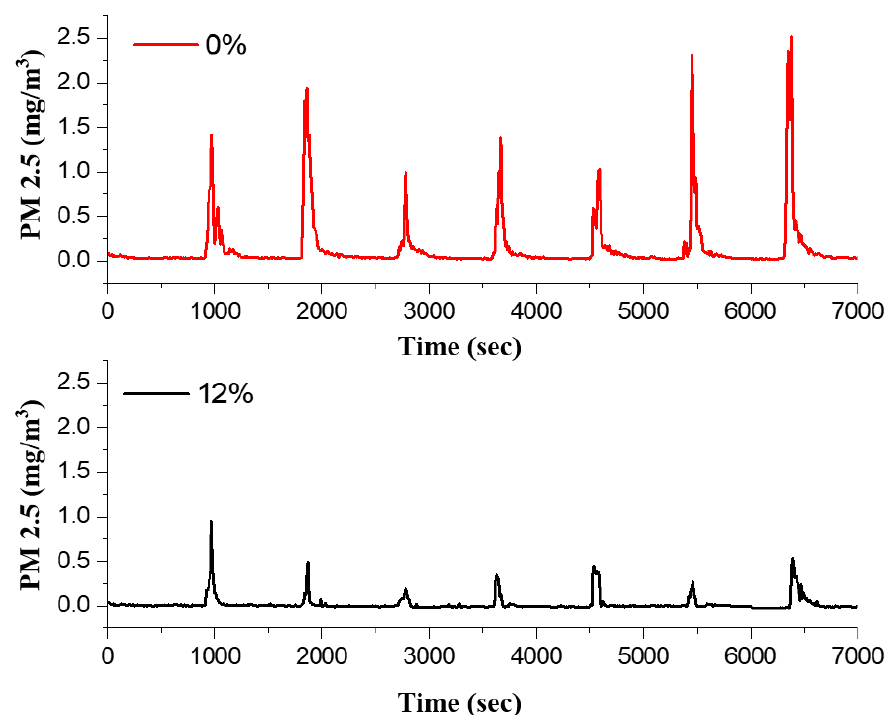
Figure 13. PM 2.5 dust generation due to human activity in soil samples coated with 0% and 12% coating solution.